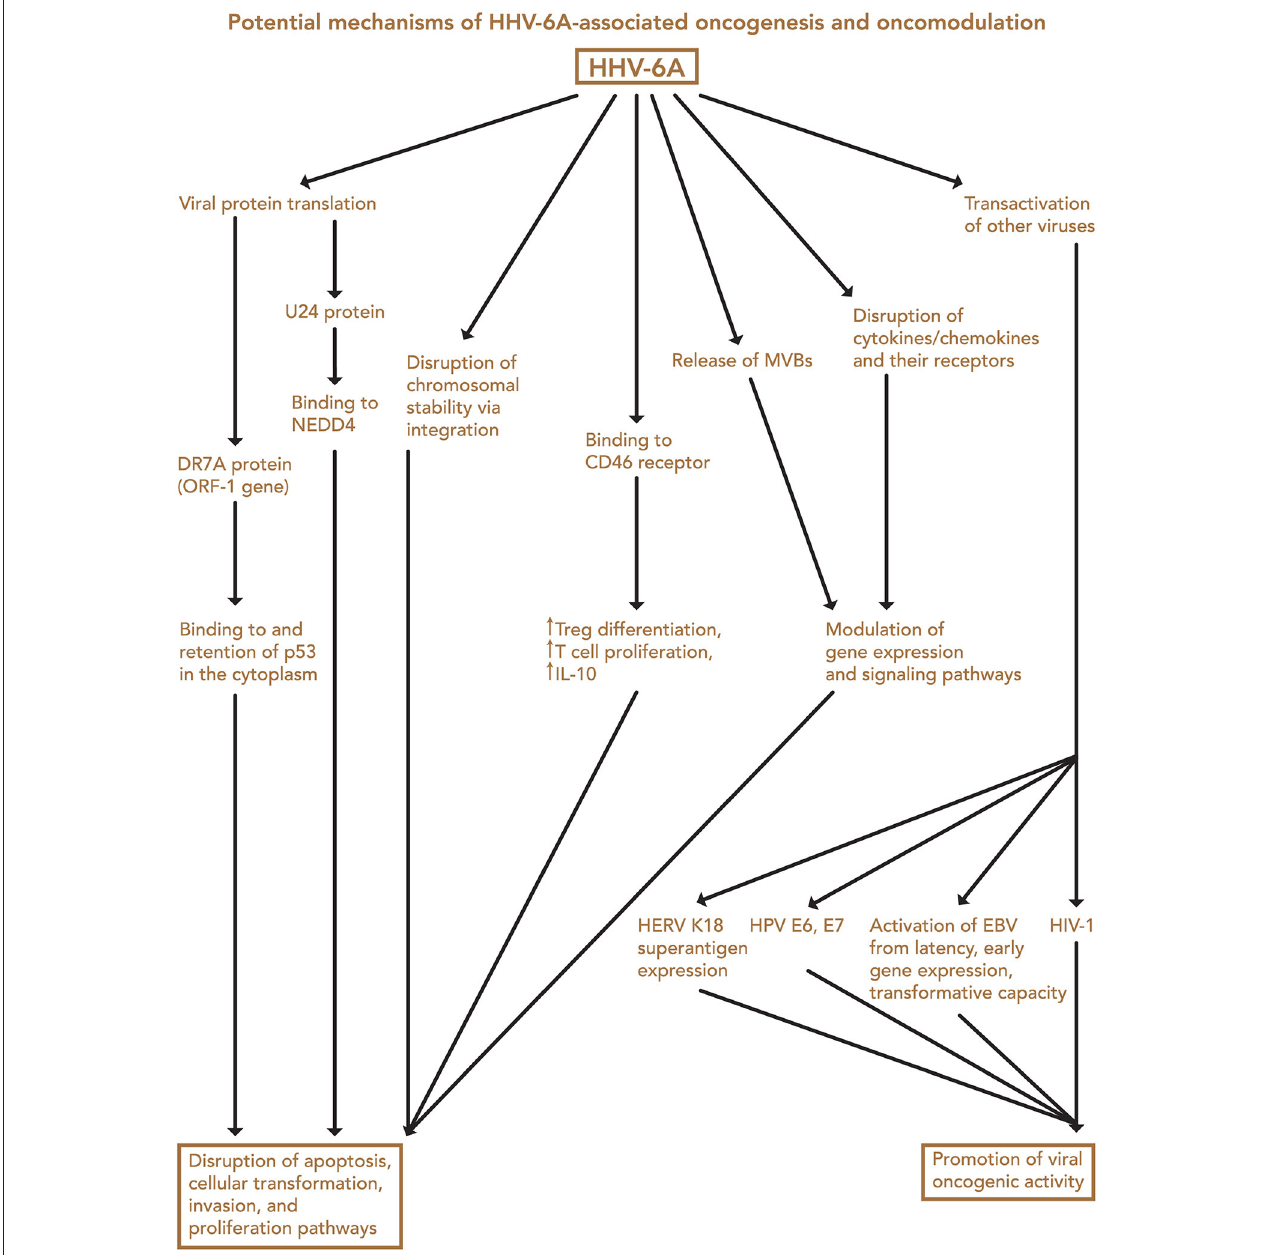
FIGURE 3 | Potential mechanisms of HHV-6A-associated oncogenesis and oncomodulation. Several HHV-6A-mediated changes may contribute to disruption of apoptosis, cellular transformation, invasion, and proliferation pathways, and transactivation of other viruses may contribute to their oncogenic activity. EBV, Epstein-Barr virus; HERV, human endogenous retrovirus; HPV, human papillomavirus; HIV-1, human immunodeficiency virus-1; MVB, microvesicular bodies; Treg, regulatory T